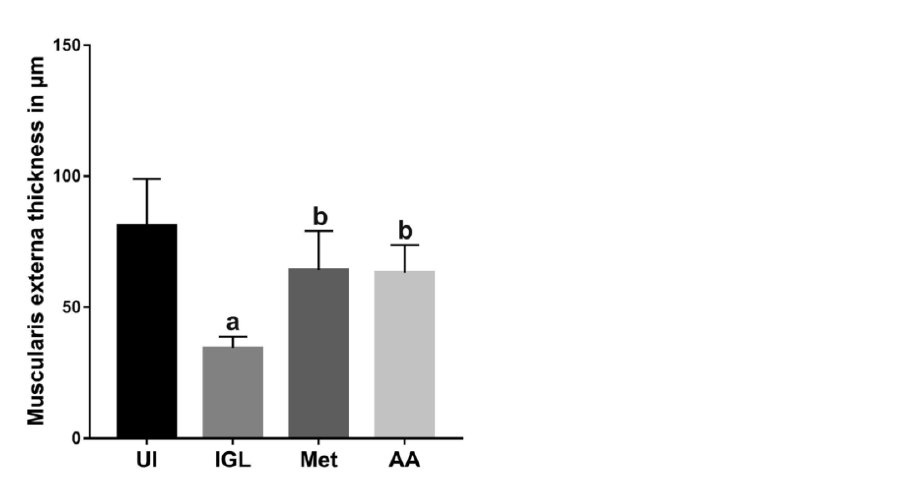
Figure 9. Treatment with A. annua restored pathological changes in muscularis externa due to G. lamblia infection. ( a ) Representative intestinal tissue from uninfected animals showing well-formed muscularis externa composed of smooth muscle fibers arranged in two layers; inner circular (CM) and outer longitudinal (LM) layers. ( b ) Representative intestinal tissue from infected untreated animals with extensively vacuolated muscle fibers (arrows) and decreased thickness of muscularis externa. ( c ) Representative intestinal tissue from infected animals treated with metronidazole with a few muscle fibers with vacuolation (arrows). ( d ) A representative tissue from small intestine of animals infected and treated with A. annua extract showing well-formed muscularis externa layers and a few fibers with vacuolation (arrows). In all panels, the vertical lines with brackets indicate the muscularis externa thickness. Scale bar = 30 µm.